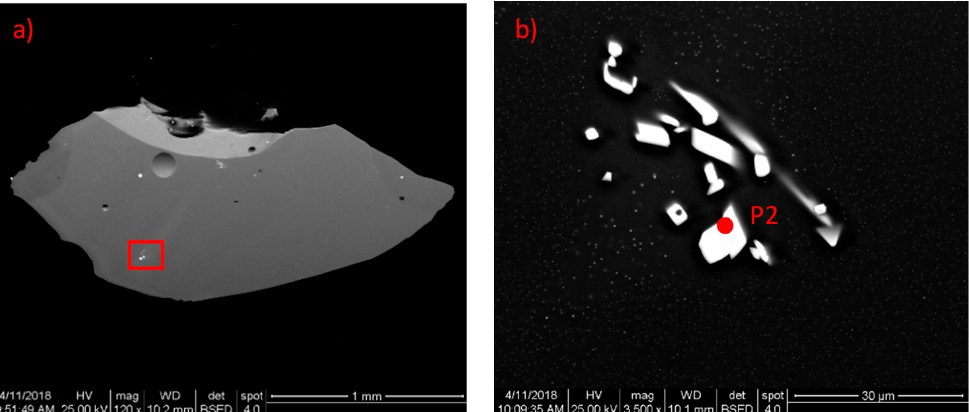
Figure 20. BSE image of ( a ) the micro-texture of the vitreous matrix, with ( b ) sporadic micrometric crystals showing an anhedral habit, found as small aggregates (SSV_R1 red natron-based glass tessera from the monastic complex of San Severo in Classe, Ravenna—unpublished data).